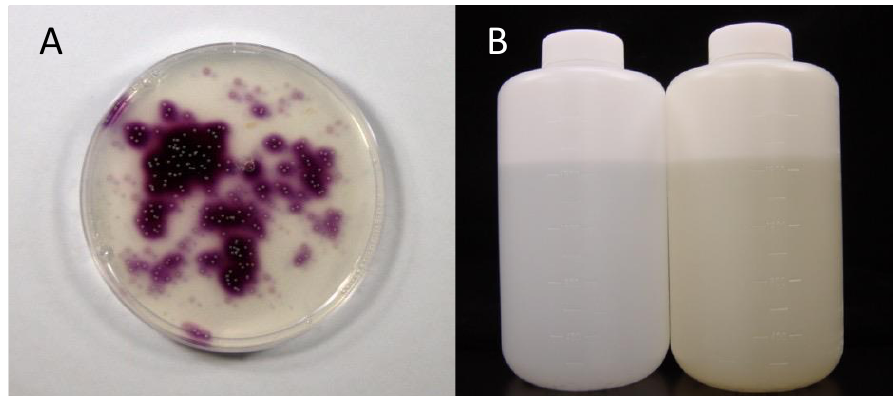
Figure 1. ( A ) Isolation of Iodidimonas strains from natural gas brine water. Brine water was spread on the marine agar 2216 medium containing iodide and soluble starch. Note that bacteria of the genus Iodidimonas produce purple pigments due to the iodine – starch reaction. ( B ) Enrichment of Iodidimonas species in natural seawater. Natural seawater (left) was supplemented with iodide and incubated for 21 days at 30 °C (right). Note that the color of seawater changes to yellow due to the formation of molecular iodine.